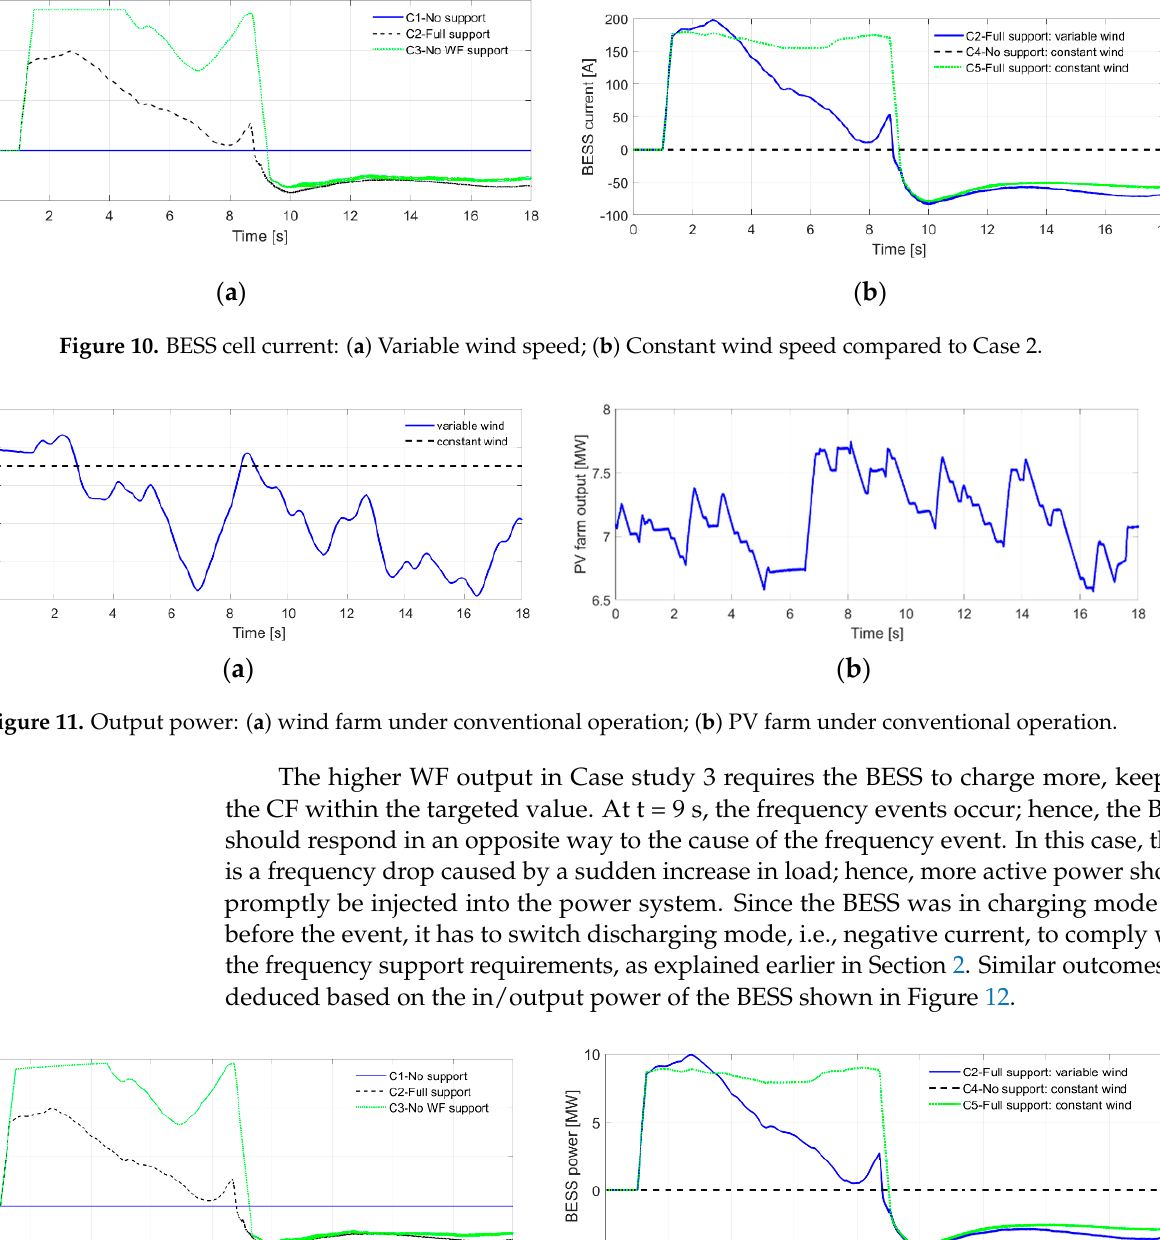
Figure 12. BESS total power: ( a ) variable wind speed; ( b ) constant wind speed compared to Case 2.